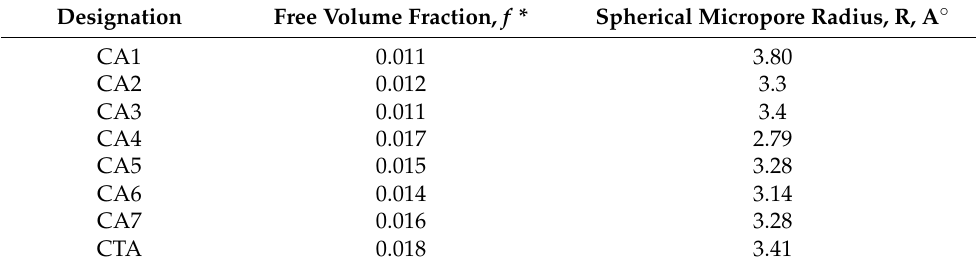
Table 3. Free volume characteristics of water-free CA